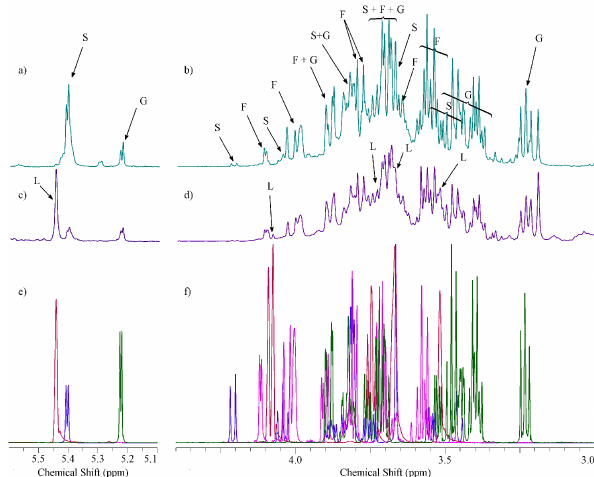
Figure 4. 500MHz δ 3.0–4.4ppm and δ 5.1–5.6ppm 1H-NMR seg- ments for the largest (a, b) and smallest particles sizes (c, d) and reference NMR spectra (e, f) of levoglucosan (red), glucose (green), sucrose (blue) and fructose